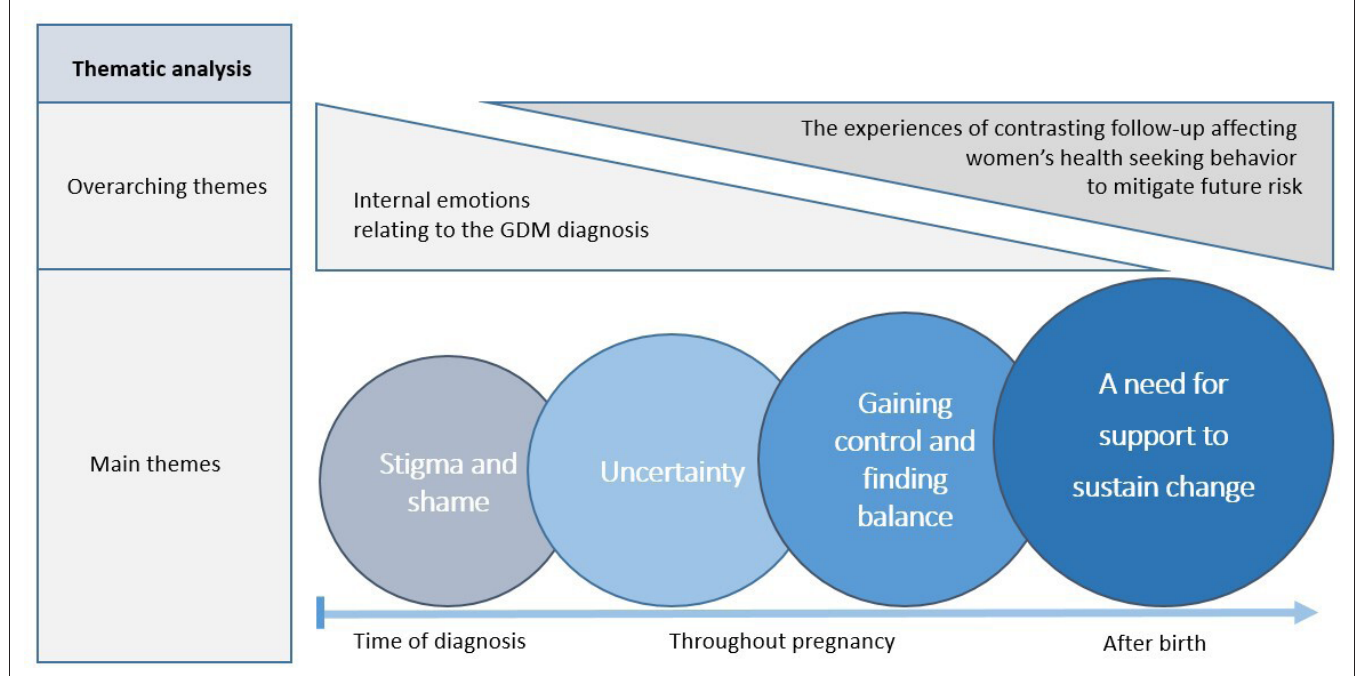
Figure 2 Relationship between overarching themes and main themes along the time course. GDM = gestational diabetes